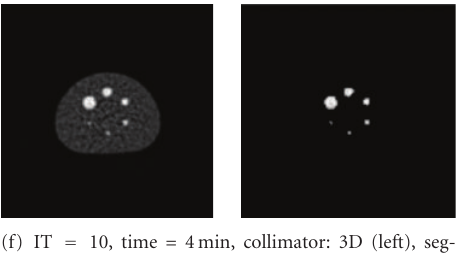
Figure 19: Segmented results achieved at IT value (10), where the best results detected.